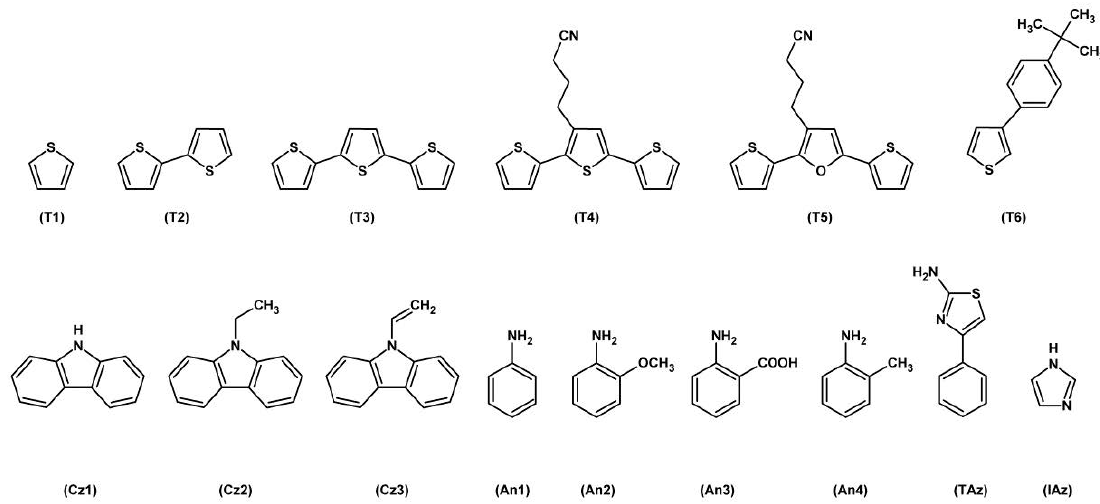
Figure 4. Chemical structures of non-pyrrole co-monomers used for electrochemical